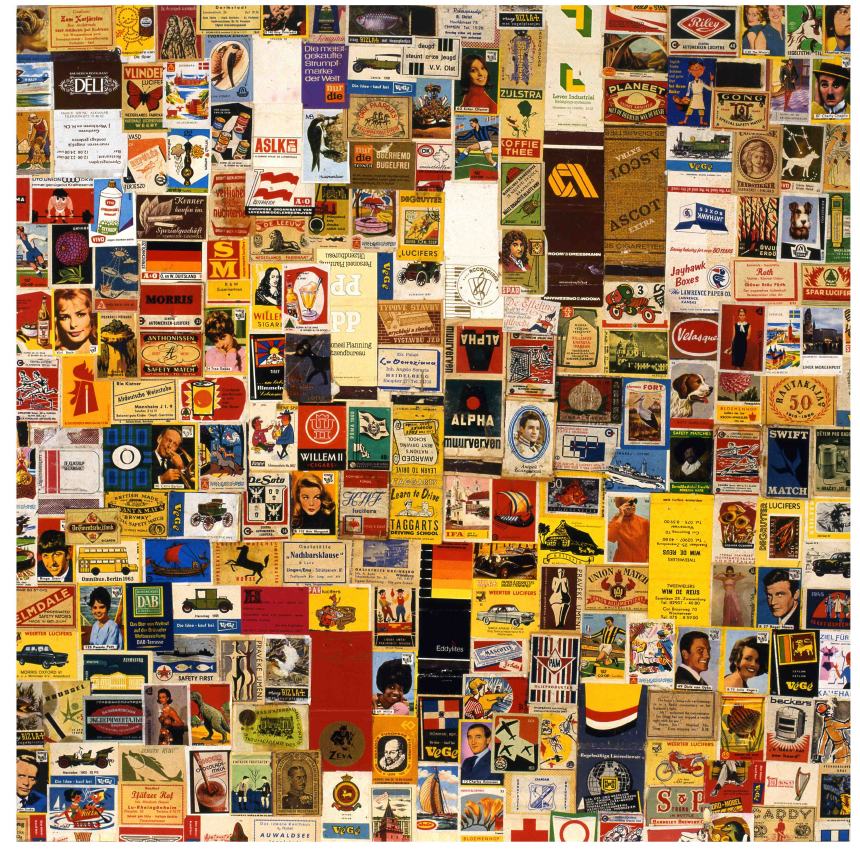
Figure 1: Rob Scholte: matches,